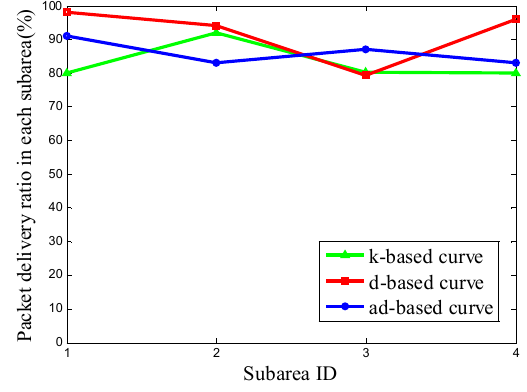
Figure 18. The PDR of k-based, d-based and adjustable d-based curve in node deployment (a): C 1 , C 2 , C 4 are deployed with 50 nodes and C 3 is deployed with 650 nodes.